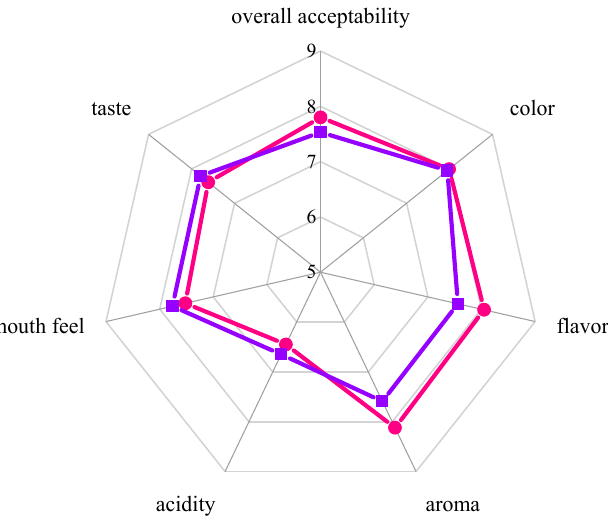
Figure 6. The sensory profile of S. cerevisiae SC125-fermented ( ● ) and control ( ■ ) beverages.